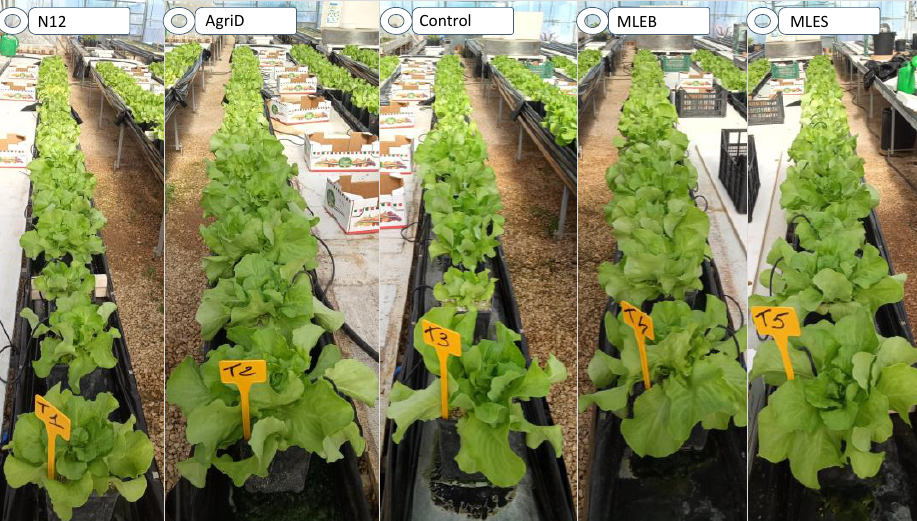
Figure 3. Overview of lettuce plants at harvest time treated with different biostimulants.